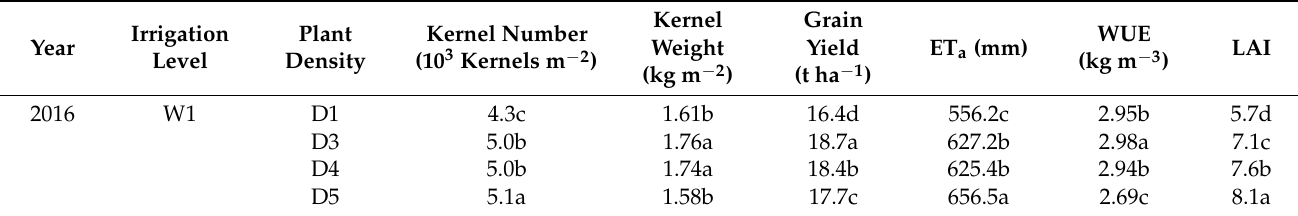
Table 2. The grain yield, kernel number, kernel weight, evapotranspiration, water use efficiency, and LAI of maize under different treatments in 2016 and